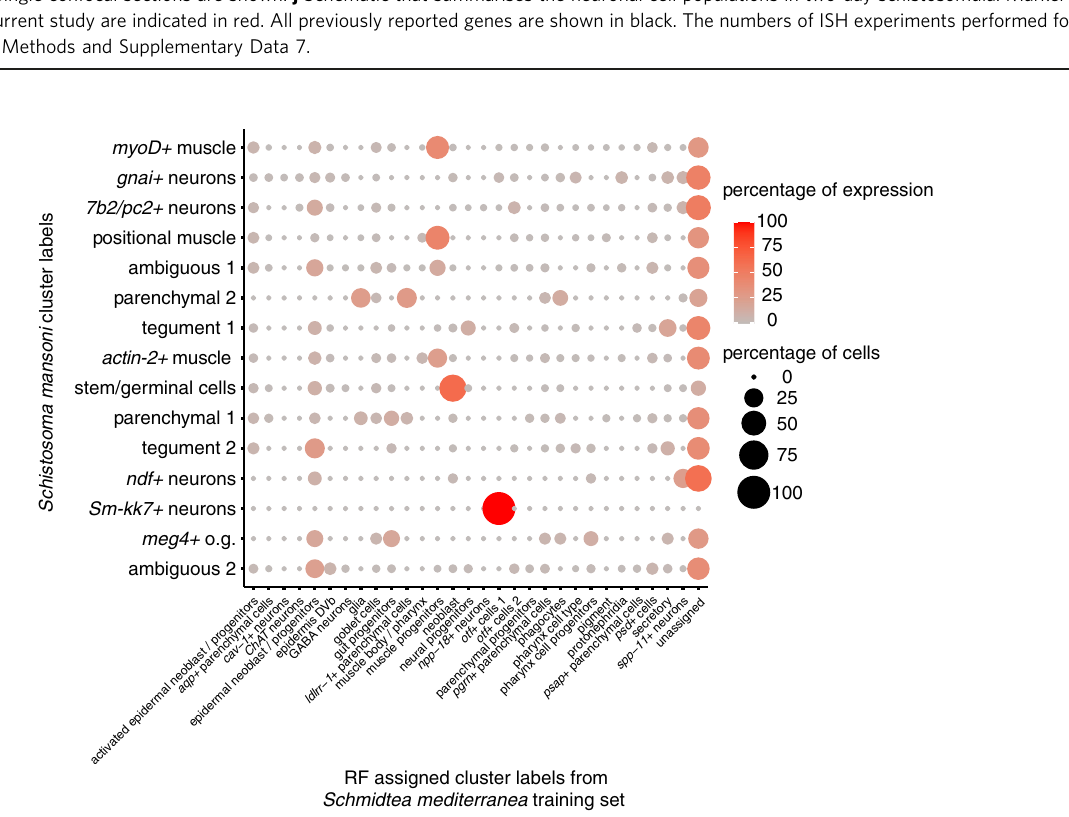
Fig. 6 Heterogeneity in cells of schistosomula nervous system. a Expression pro fi les of cell marker genes that are speci fi c or enriched in the neuronal clusters. Genes validated by ISH are marked in red. b Cephalic ganglia marked by sWGA lectin shows co-localisation with 7b2 (Smp_073270)(white arrow), MIP. c WISH of 7b2 (Smp_073270) in adult male. d , e FISH of 7b2 (Smp_073270) in d cephalic ganglia and e body region of adult worms, single